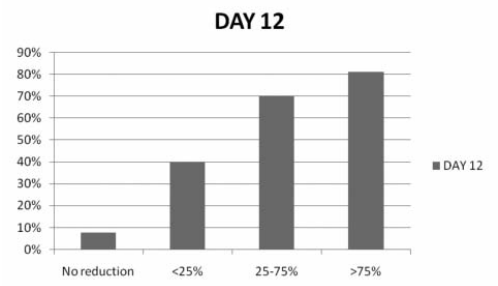
Figure 1. Percentage of the population who became independent of dialysis and the reduction in serum FLCs at day 12.